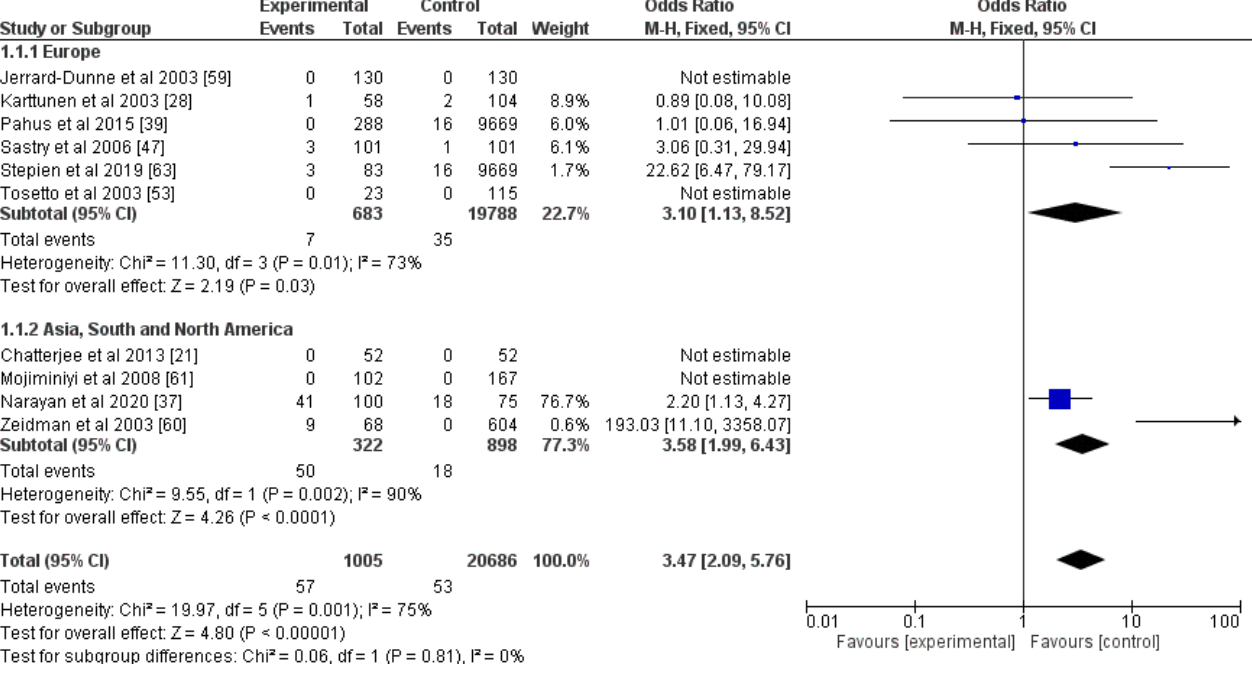
Figure 6. Forest plot for antithrombin and subgroup analysis according to geographical localization of the studies. Blue squares indicate odds ratios. Black rhombi indicate overall effect. Vertical line indicates null effect, and horizontal lines indicate values of odds